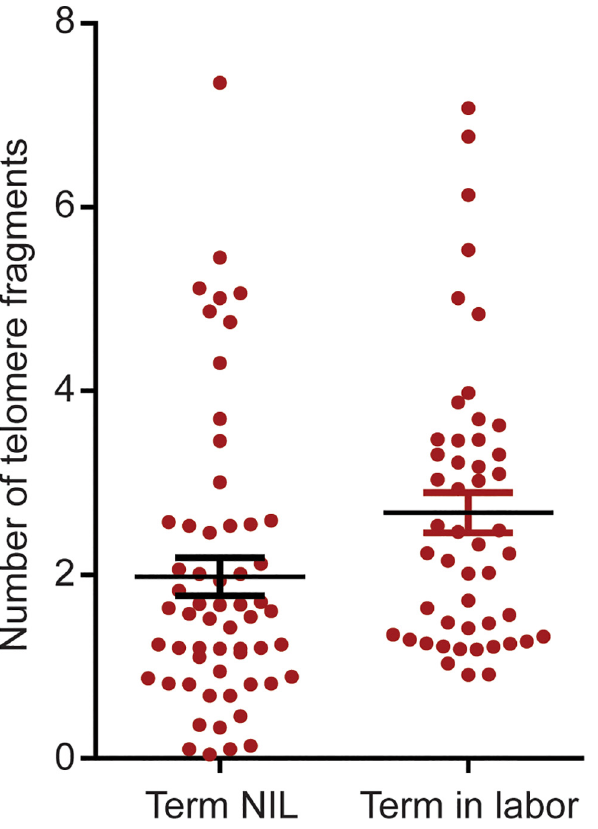
Fig 1. Quantitation of telomere fragments in human amniotic fluid. Scatter plot representing the number of telomere fragments detected in amniotic fluid from normal term not in labor (NIL) and term in labor samples. The distribution of telomere fragments significantly differs between groups (p = 0.04;